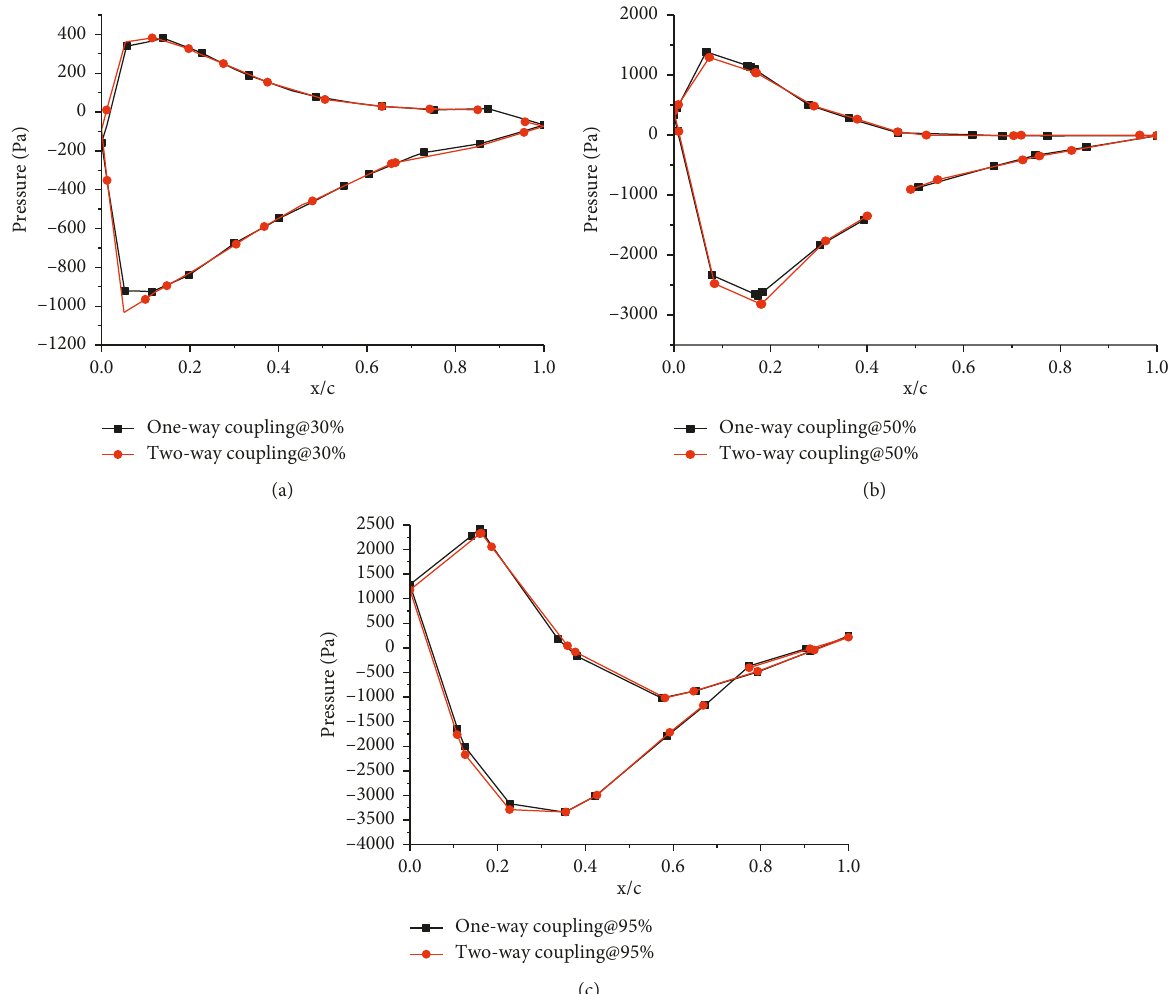
Figure 7: Pressure distribution on spanwise sections of the blade in one-way and two-way FSIs: (a) x /chord � 0.3; (b) x /chord � 0.5; (c) x /chord � 0.95.